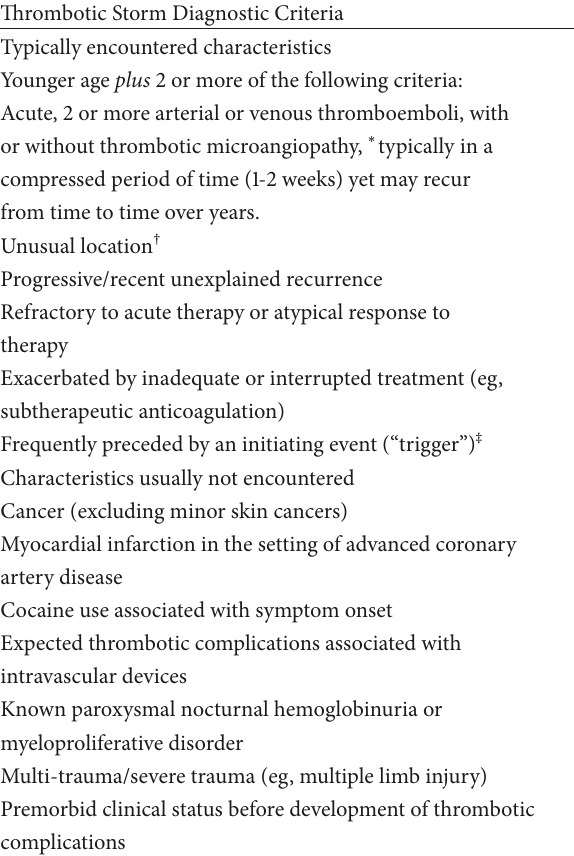
Table 1: Diagnostic criteria of thrombotic storm reproduced with permission from Kitchens et